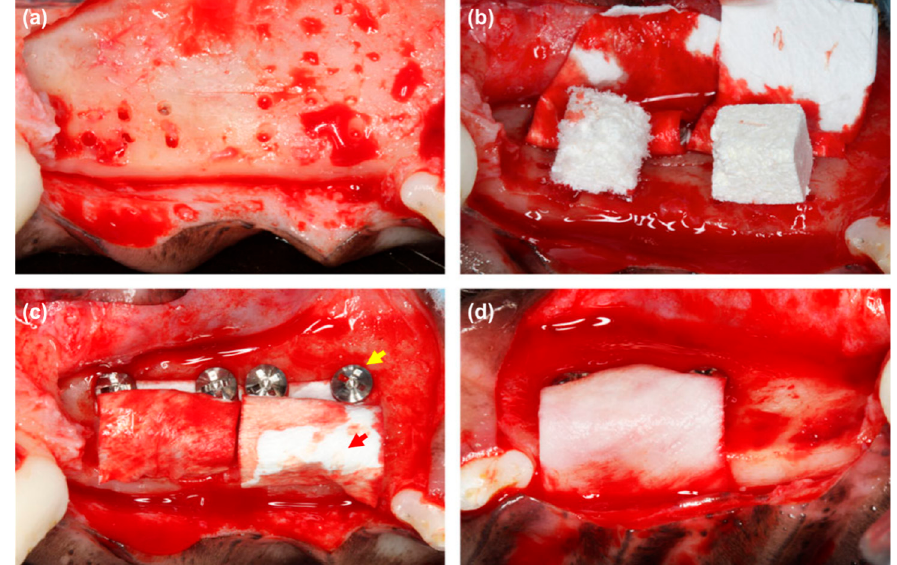
Figure 1. Clinical photographs of the experimental sites: ( a ) A full-thickness flap was elevated, and the bone bed was prepared by perforating the cortical bone; ( b ) Assigned bone substitutes and membranes were applied. The left block is bovine hydroxyapatite incorporated into a non-cross-linked collagen matrix, and the right block is porcine hydroxyapatite incorporated into a cross-linked collagen matrix; ( c ) The bone substitutes were covered by the membranes (red arrow), which were stabilized using two pins (yellow arrow). Both membranes are cross-linked collagen membrane; ( d ) An occlusal view of the opposite side. The non-cross-linked collagen membrane is applied. Reprinted with permission from John Wiley and Sons [40].